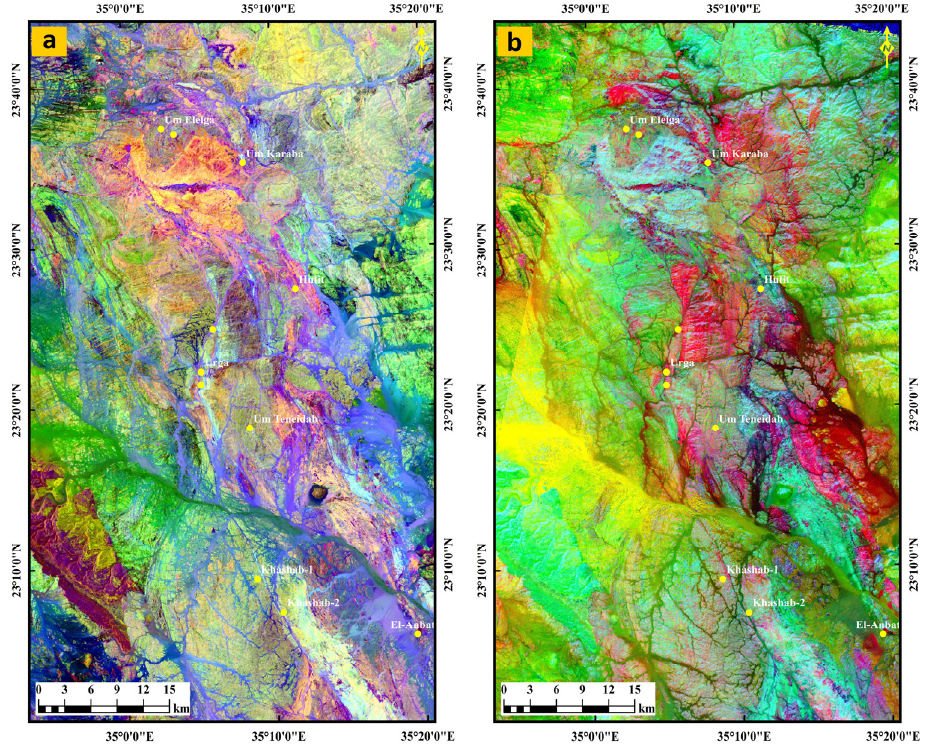
Figure 5. False-color composite of principal component analysis (PCA) of ( a ) Landsat-8 RGB-PC2, PC4, PC5 and ( b ) ASTER RGB-PC6, PC3, PC1.